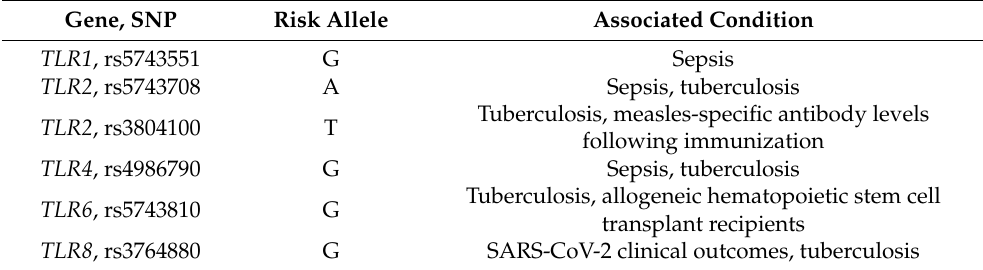
Table 1. Selected SNPs in TLR genes associated with pathological conditions.